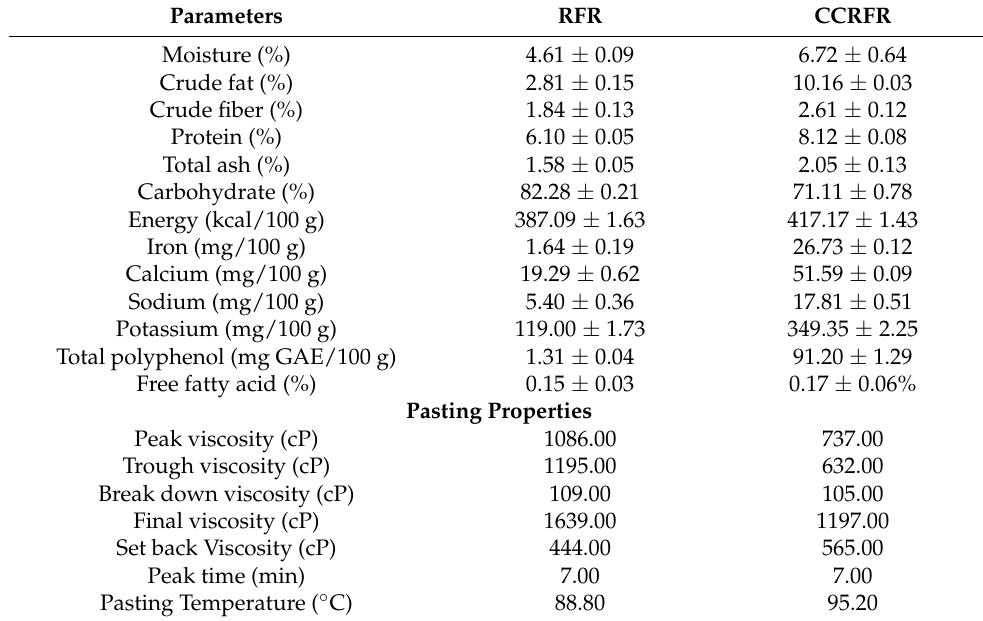
Table 5. Comparative chemical and pasting characteristics of RFR and